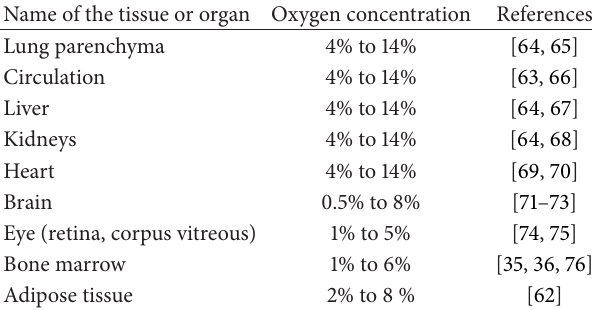
Table 1: Oxygen concentration in different organs and tissues. Name of the tissue or organ Oxygen